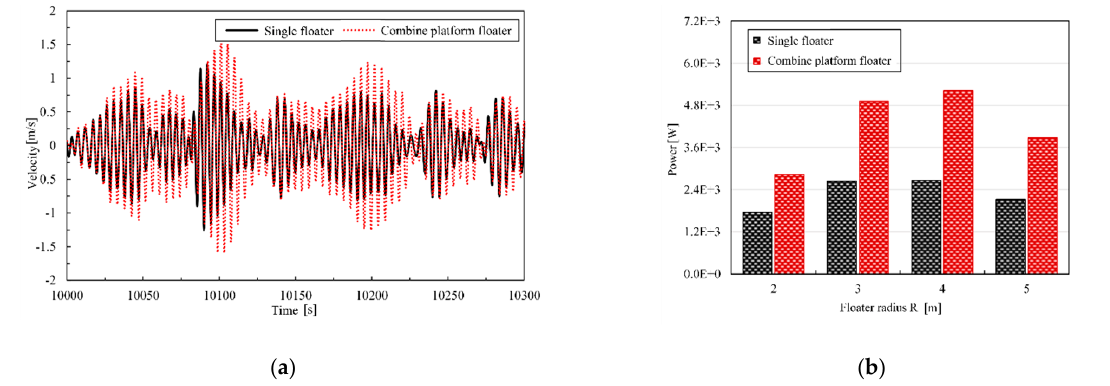
Figure 14. Comparison of velocity and power generation of floaters with different sizes under irregular waves: ( a ) floater velocity comparison; ( b ) power comparison.